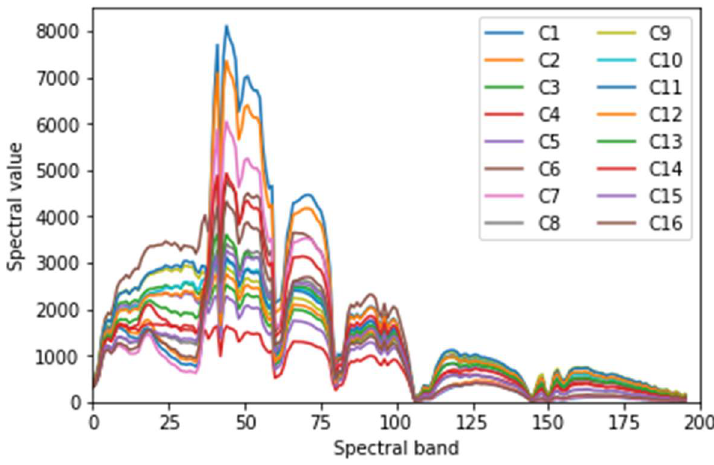
Figure 7. Mean spectral signatures of 16 classes in the Salinas dataset.